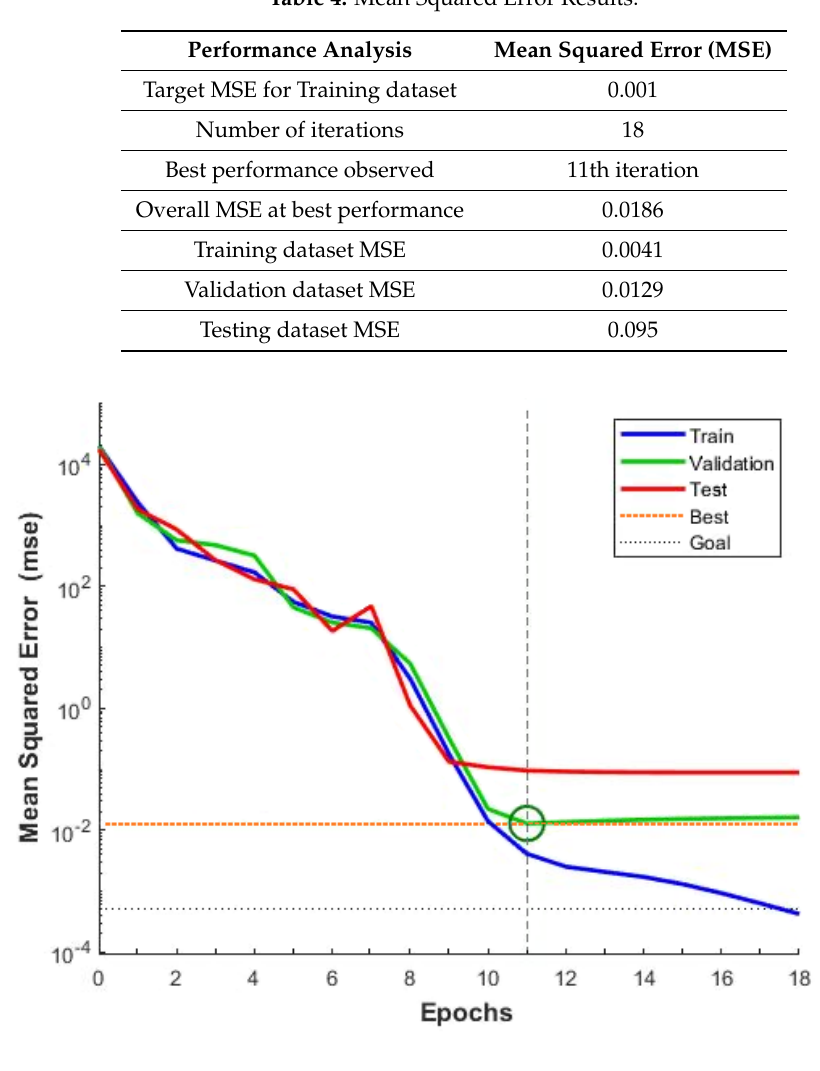
Figure 6. Neural Network